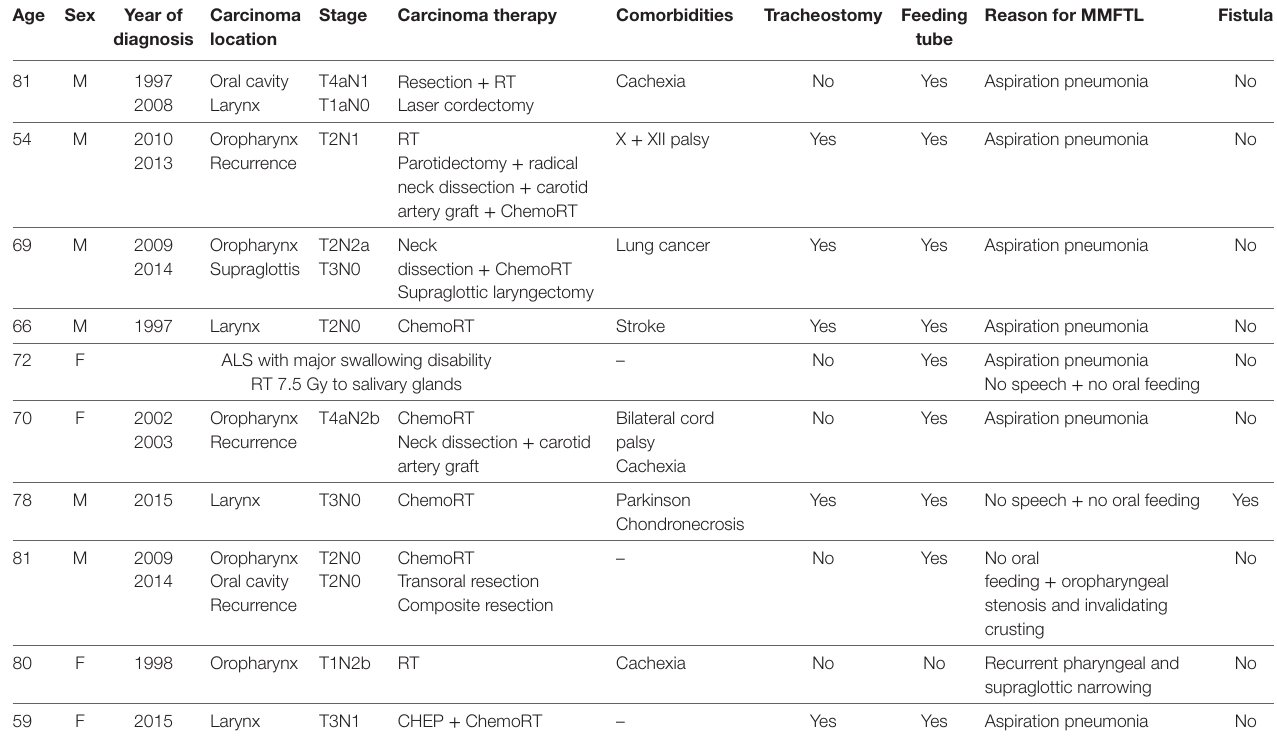
TaBle 1 | Patient